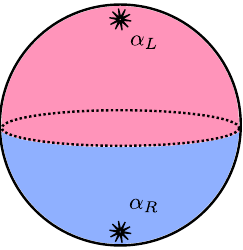
Figure 3 . The dimension of the Hilbert space for the above con(cid:12)guration gives the tunneling (cid:11) R = dim matrix coe(cid:14)cients: W (cid:11) L H S 2 (cid:11)L;(cid:11)R